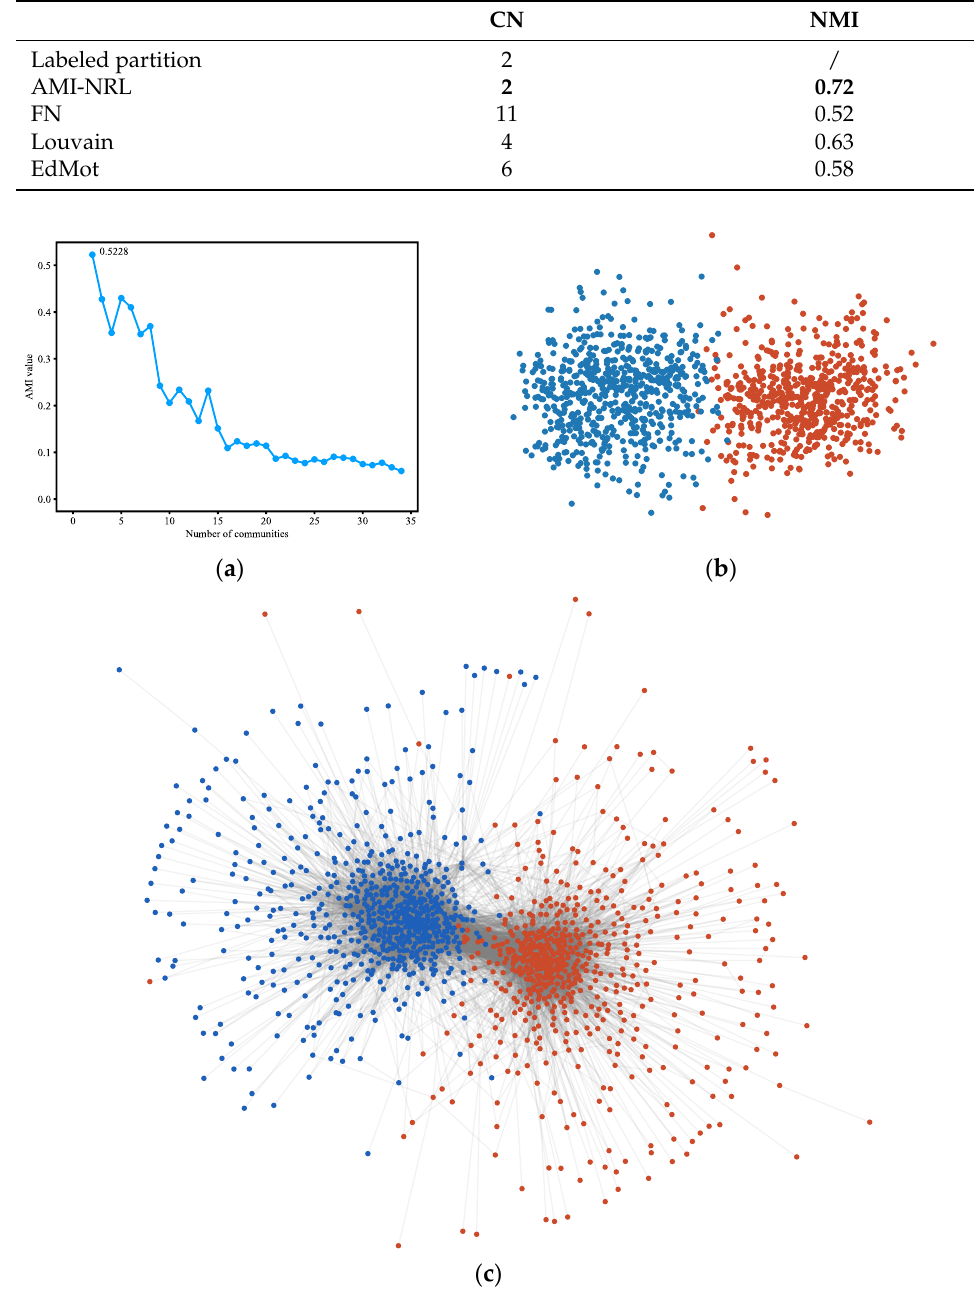
Figure 5. ( a ) AMI variation graph of adjacent partitions of Polblogs. ( b ) Vectors representing each node of Polblogs. ( c ) Result of community detection on Polblogs.